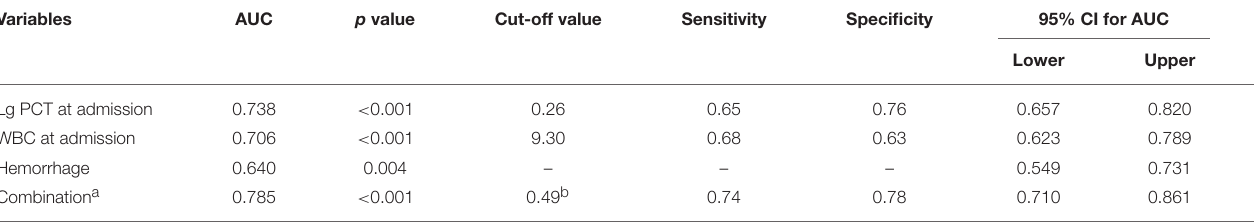
TABLE 3 | Predictive values of parameters for the severity of HFRS.